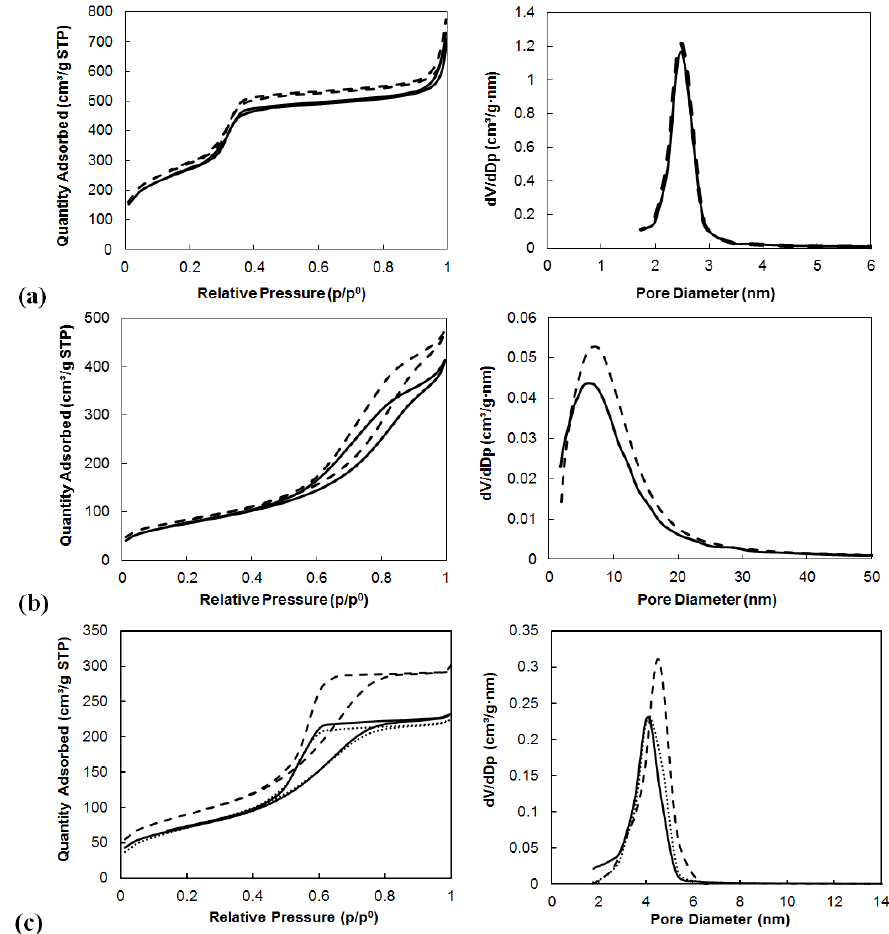
Figure 1. Adsorption and desorption isotherms and pore size distribution of ( a ) MCM-41 (dashed line) and MTO/MCM-41 (line); ( b ) Siral 20 (dashed line) and MTO/Siral 20 (line) and ( c ) MA 5 (dashed line), ZnCl /MA 5 (dots) and MTO/ZnCl /MA5 (line), (immobilized 2 2 amount was 15 mg methyltrioxorhenium (MTO) on 100 mg of pure supports and 5 mg MTO on ZnCl 2